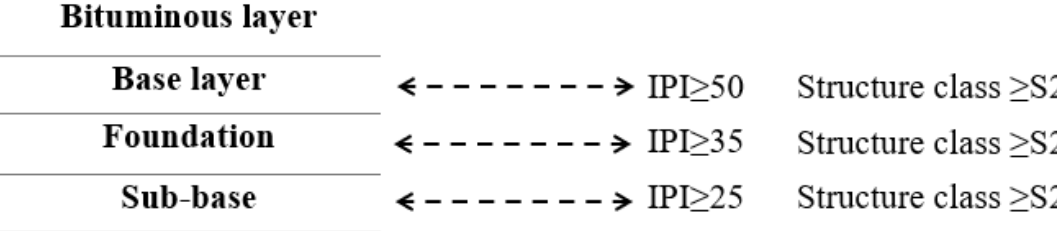
Figure 7. Scheme of road section and recommended engineering characteristics (SETRA-LCPC, 1998 [23]).